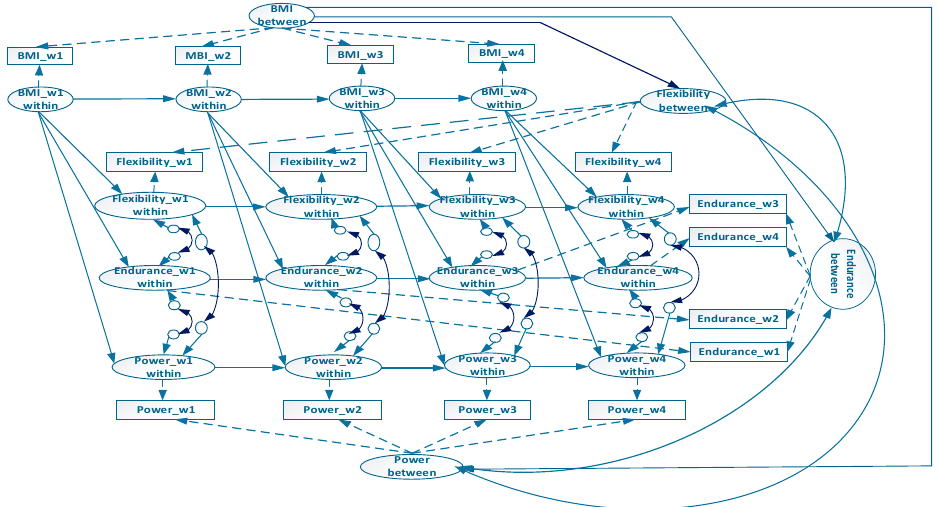
Figure 1. Graphical representation of our four-wave random-intercept panel model on associations between body mass index (BMI), flexibility, muscular endurance, and explosive power (dotted line indicates that the coefficients are fixed to 1.00). w1, wave one; w2, wave two; w3, wave three; w4, wave four.